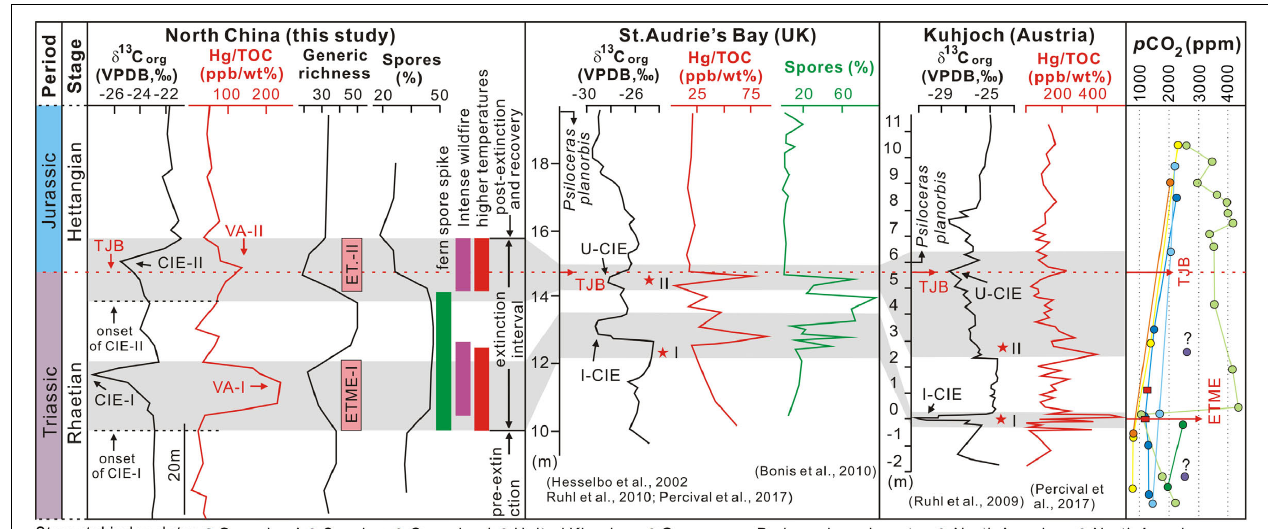
FIGURE 6 | Correlations of δ 13 C org , Hg/TOC ratios, wildfire, spores (%), plant generic richness (number), and p CO 2 across the Triassic-Jurassic transition. Paleoclimate change inferred from palynology data. δ 13 C org , Hg/TOC ratios, and spore data from the St. Audrie’s Bay and Kuhjoch sections by Hesselbo et al. (2002), Ruhl et al. (2009), Bonis et al. (2010), Ruhl et al. (2010), and Percival et al. (2017) respectively; p CO 2 curves modified from Slodownik et al. (2021) and references therein. TJB, Triassic-Jurassic boundary; VPDB, Vienna Pee Dee Belemnite; CIE-I to CIE-II, from the first organic carbon isotope excursion to the